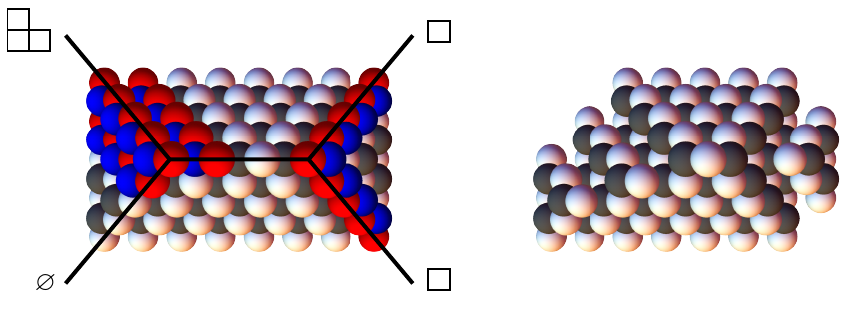
of the Figure 12 . Open BPS state with ~Y = ( { 2 , 1 } , ∅ , { 1 } , { 1 } ) in the infinite chamber C ( i ) m =4 conifold geometry. (a) The atoms that lie on the infinite rows with the cross-sections given by ~Y are colored, node 1 → red and node 2 . (b) The red and blue atoms are removed, giving the subcrystal for the open BPS states with ~Y in C ( i ) m =4